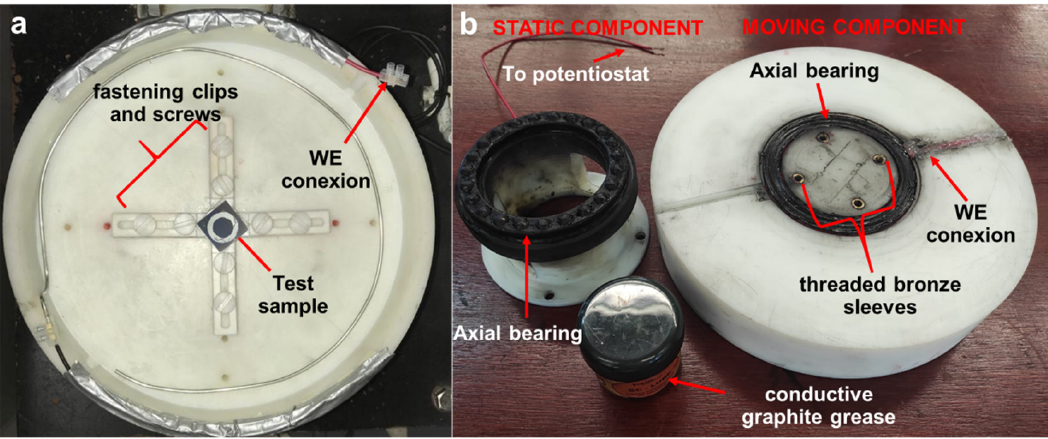
Figure 2. ( a ) Front; ( b ) back of corrosion cell.